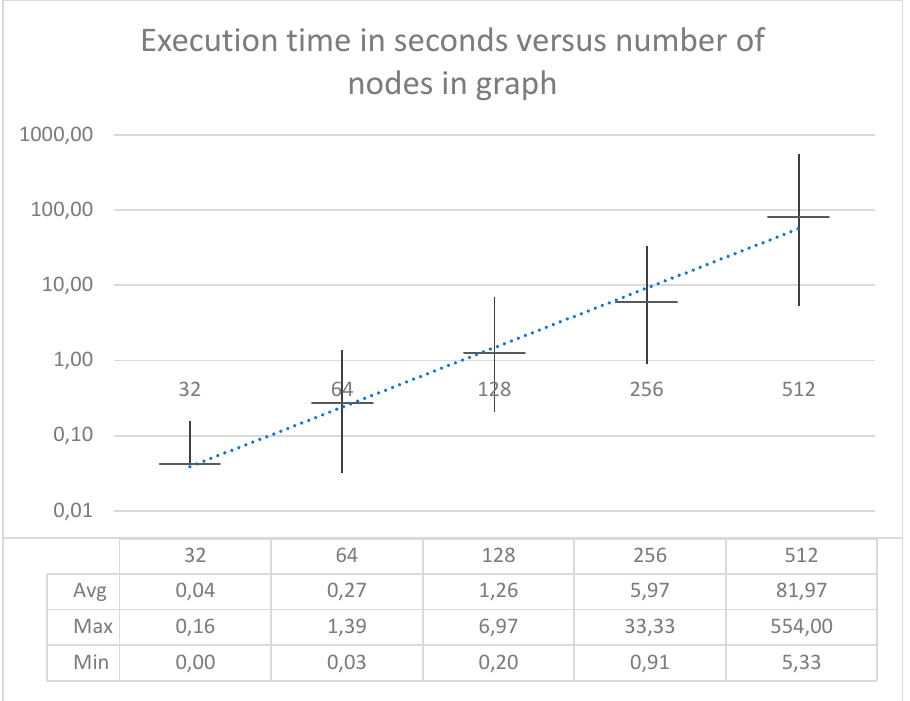
Figure 4. Sub-graph size versus execution time.